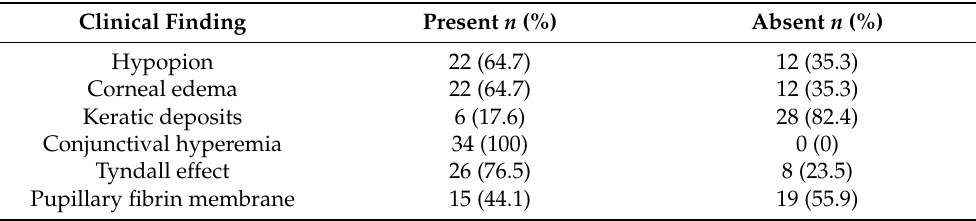
Table 2. Clinical findings among endophthalmitis cases.